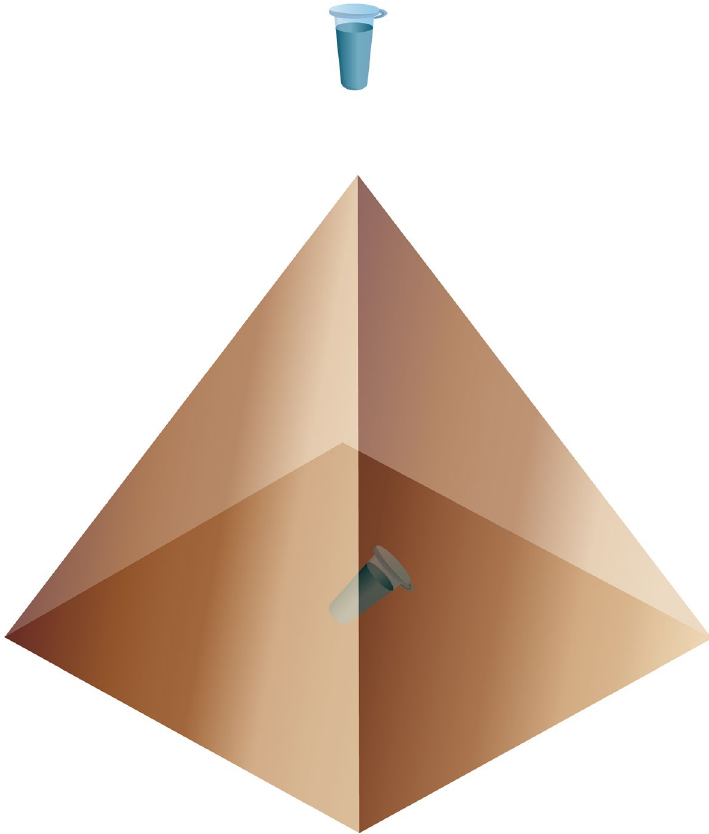
Figure 5. Experimental setup. The test tube with the HRP solution was placed either at 1 cm distance from the pyramid’s apex, or in the center of its